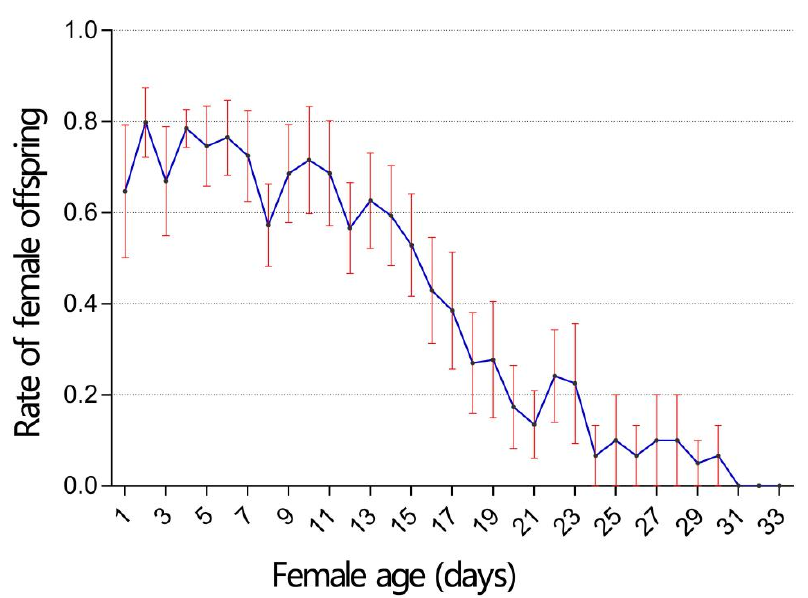
Figure 4. Rate of female offspring of T. drosophilae during the lifespan of adult females.